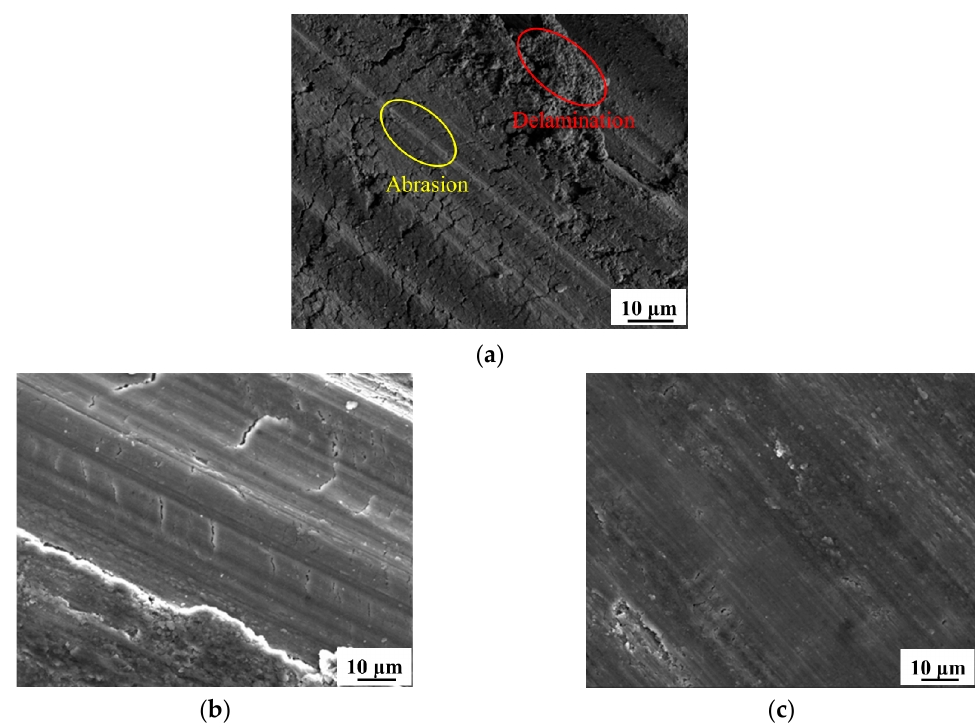
Figure 11. Surface morphology of the composite under the dry friction condition (sliding speed is 10 mm/s; load is 15 N): ( a ) PM, ( b ) PM-4p-ECAP and ( c ) PM-8p-ECAP.